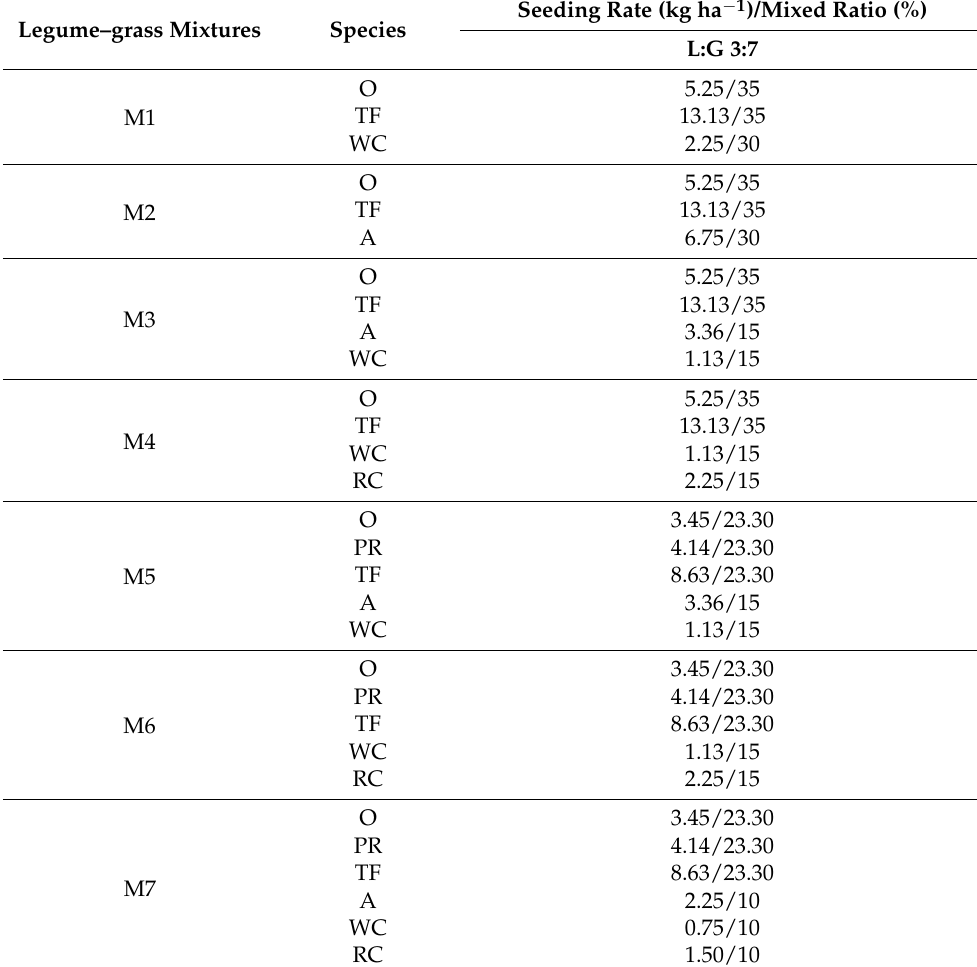
Table 3. Seeding rates of components species in the legume–grass mixtures. Legume–grass